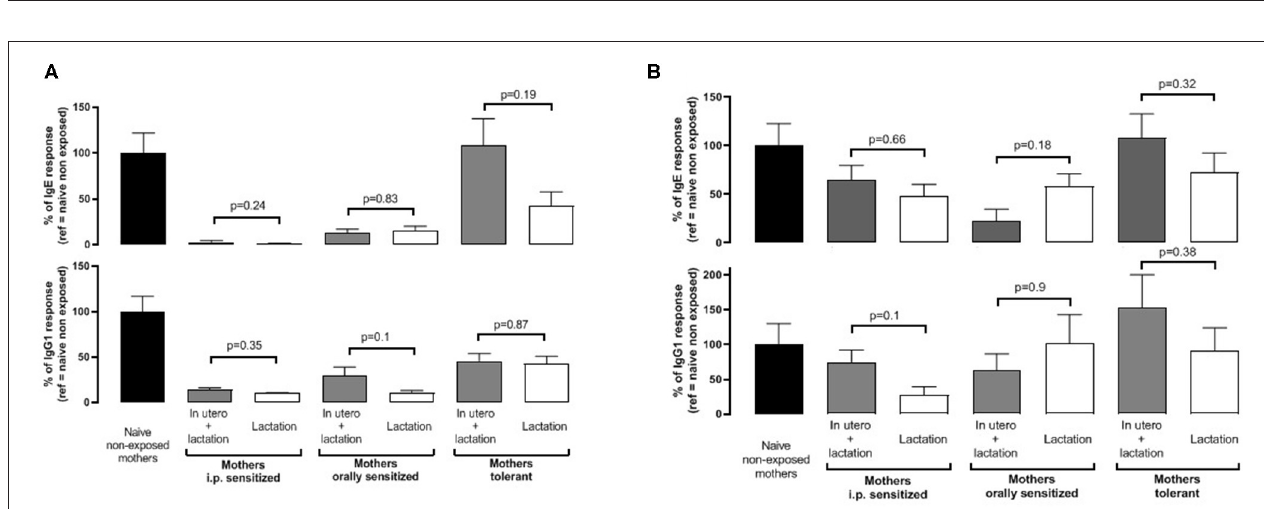
FIGURE 5 | Pups were born and fed by prenatally sensitized (i.p. or orally) or tolerant mothers, further orally exposed during lactation ( in utero + lactation), or pups from naïve mice were fostered by prenatally sensitized or tolerant mothers further orally exposed during lactation ( n = 5–12/group). BLG-specific IgE (top panel) and IgG1 (bottom panel) were assayed in plasma from progeny after one (A) and two (B) i.p. sensitizations with BLG/alum. Specific antibodies are expressed as percentage, with the mean value obtained in naive mothers not exposed during lactation used as a reference (100%). Immune response was compared between “ in utero + lactation” and “lactation” groups for a same mother pre-treatment, and p -values are indicated (Mann Whitney